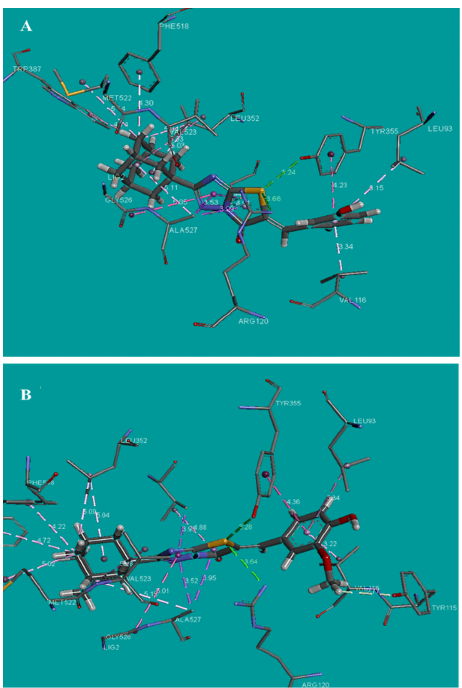
Figure 3. ( A ) Binding of 2 into the active site of COX–2, ( B ) Binding of 6 into the active site of